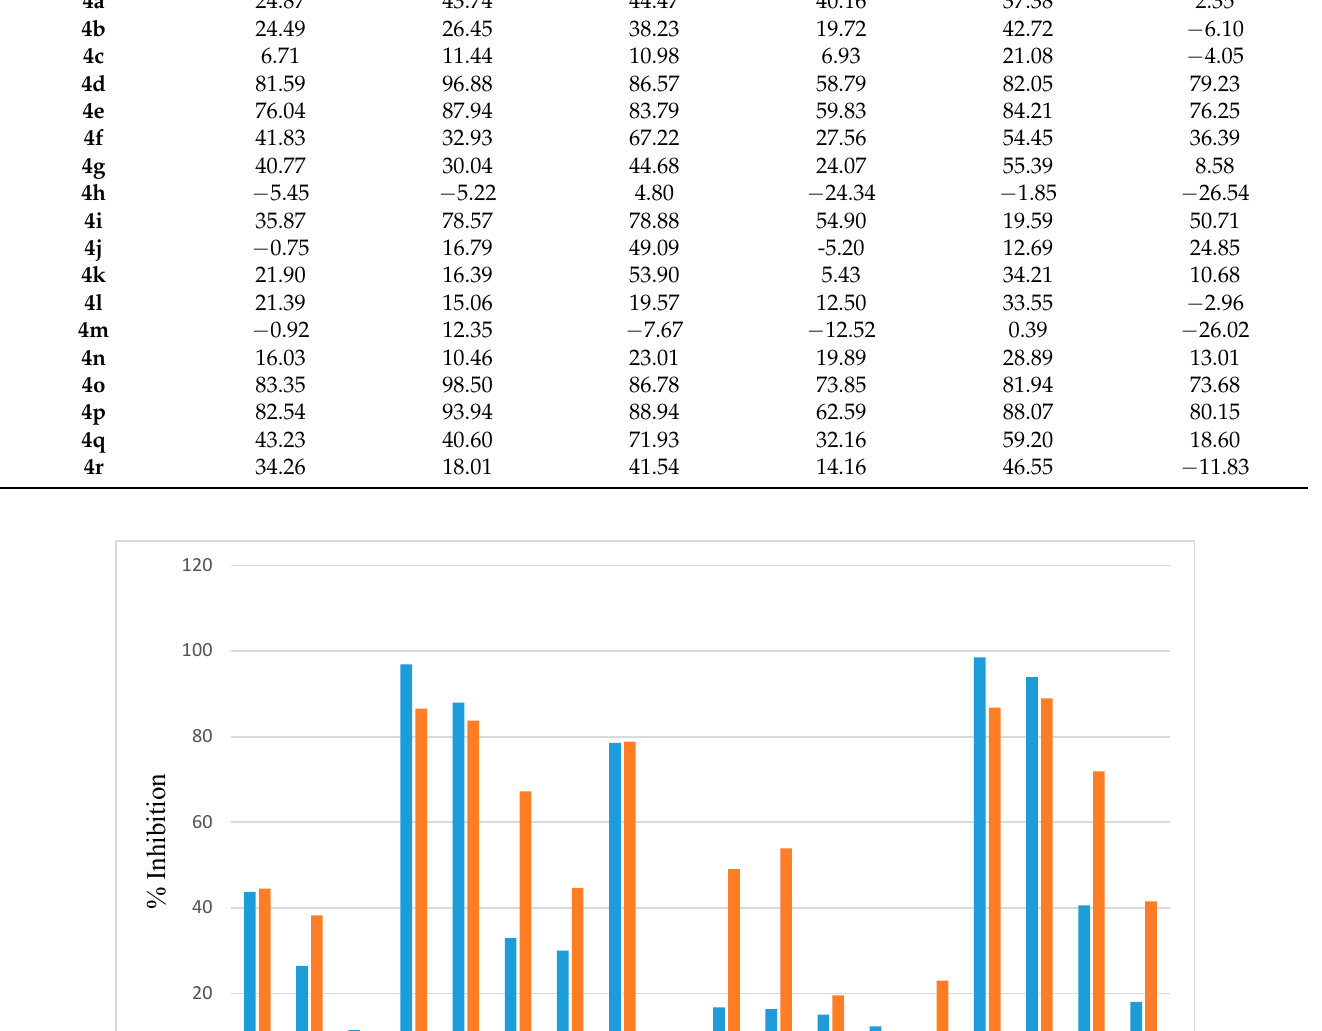
with meta-(F or Cl) substitution on the terminal phenoxy group, totally inhibited the growth of the leukemia HL-60(TB) cell line with almost 100% inhibition and showed above 90% growth inhibition for leukemia K-562. Compounds 4e , 4h , and 4p exhibited satisfactory inhibitory activity against both cell lines (78–83%), while most of the tested candidates showed moderate anti-proliferative activity against leukemia (30–60%). Table 5. Anti-proliferative activities (% growth inhibition) of the target compounds 4a – r against leukemia cell lines. Cpd. CCRF-CEM K-562 Cpd.